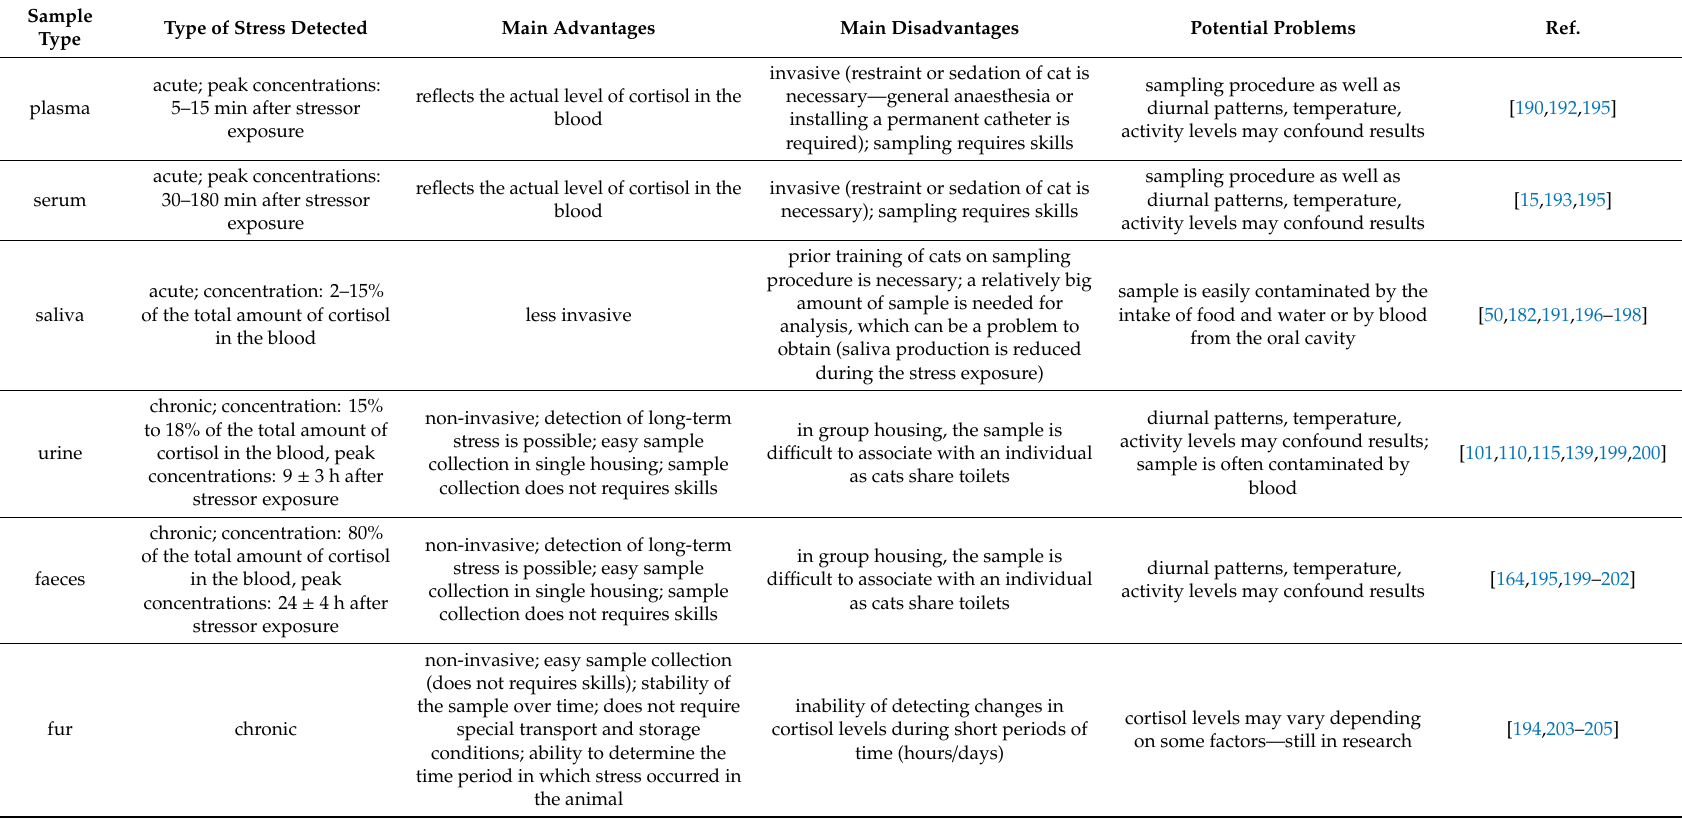
Table 2. Practicality of various types of samples that can be used to determine cortisol